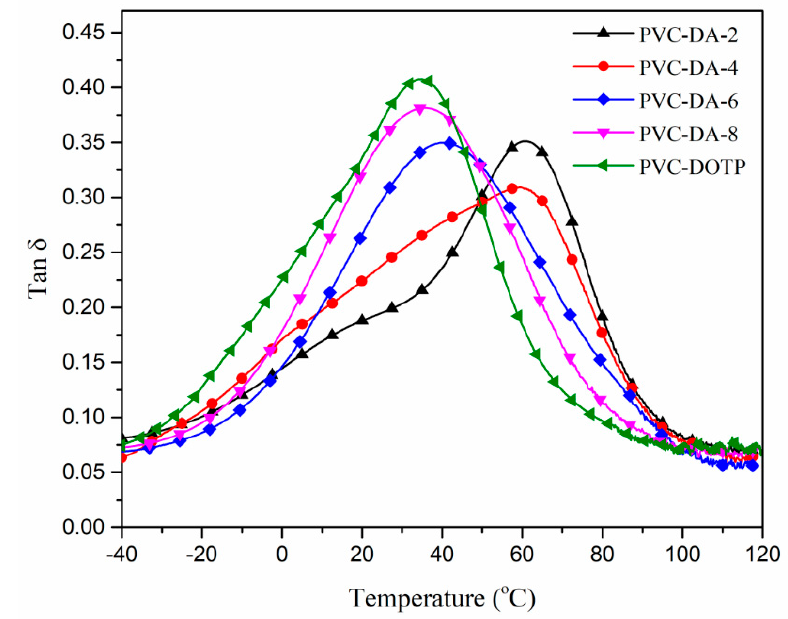
Figure 4. DMA curves of the PVC ‐ DA ‐ 2n (2n = 2, 4, 6, and 8) and PVC ‐ DOTP.